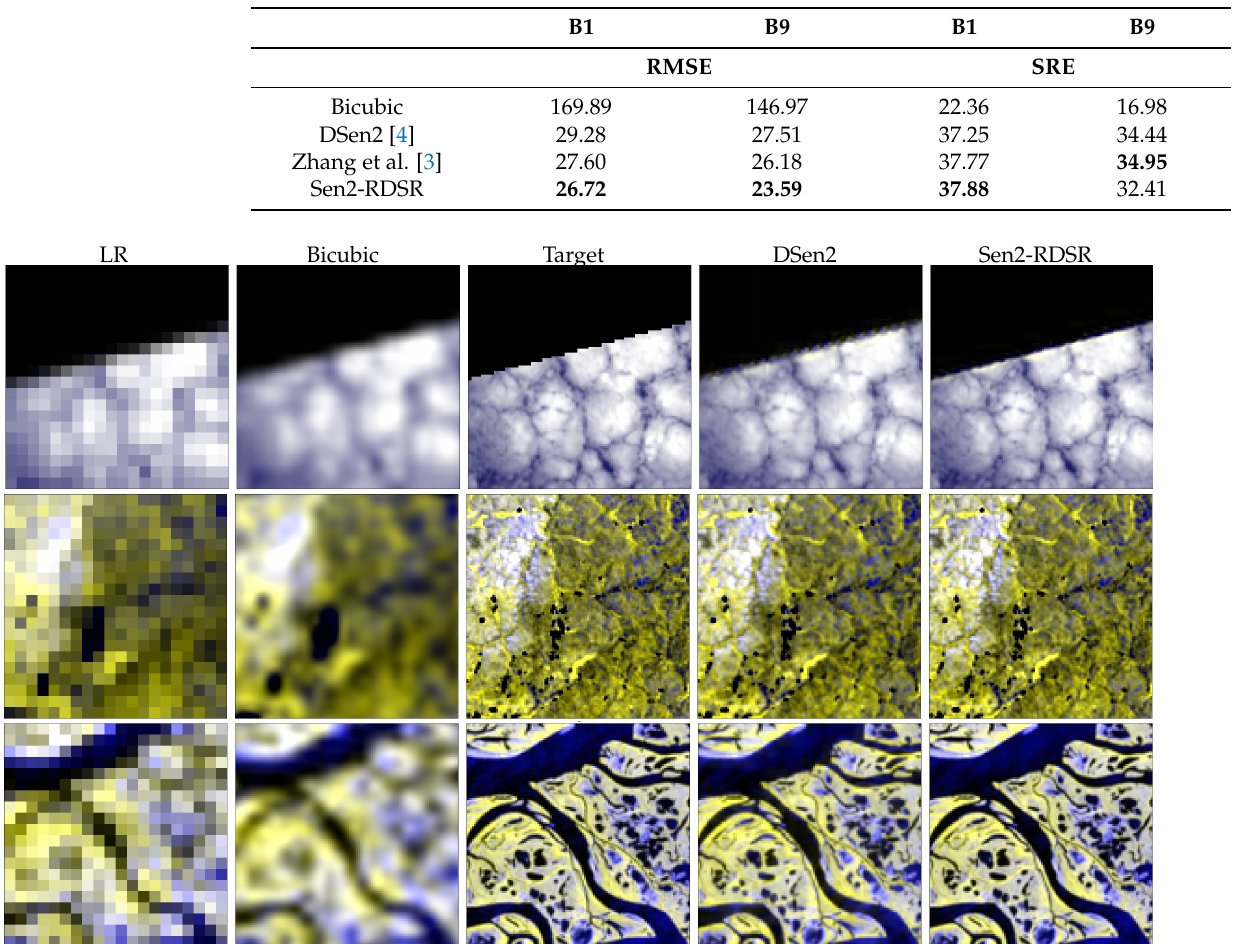
Figure 5. Sharpening results for the Sentinel-2 60 m bands. Images correspond to crops from the test set with the false-color composite {B9,B9,B1} as RGB. The first column corresponds to the original VLR 60 m bands, the second column is the bicubic interpolation, the third column is the target image, the fourth column is the result from DSen2 [4], and the fifth column is our result. The size of the images is 20 × 20 pixels for LR and 120 × 120 for the